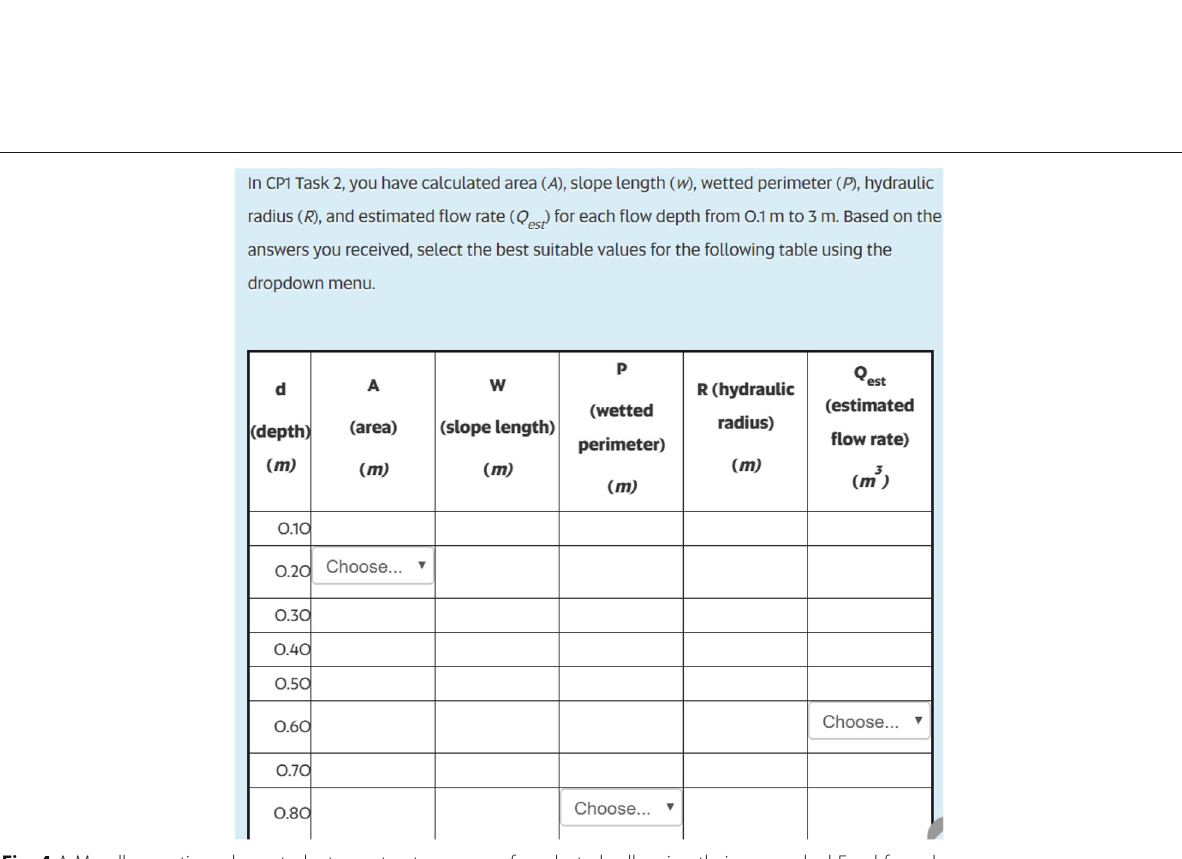
Fig. 4 A Moodle question where students must enter answers for selected cells using their pre-worked Excel